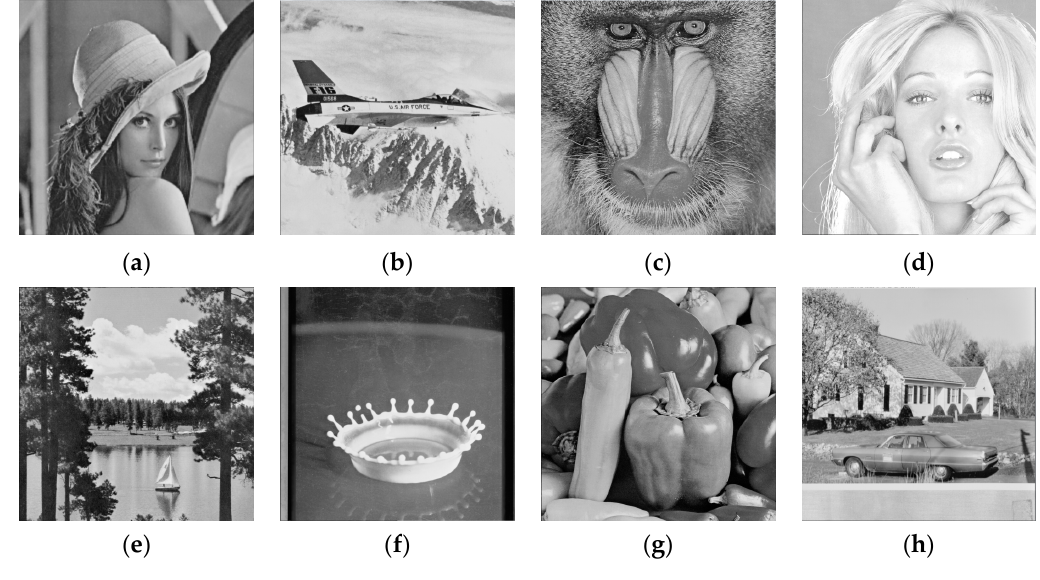
Figure 3. Eight test images. ( a ) Lena; ( b ) Jet; ( c ) Baboon; ( d ) Tiffany; ( e ) Sailboat; ( f ) Splash; ( g ) Peppers; ( h ) House. Table 1. PSNR and SSIM comparisons with various T